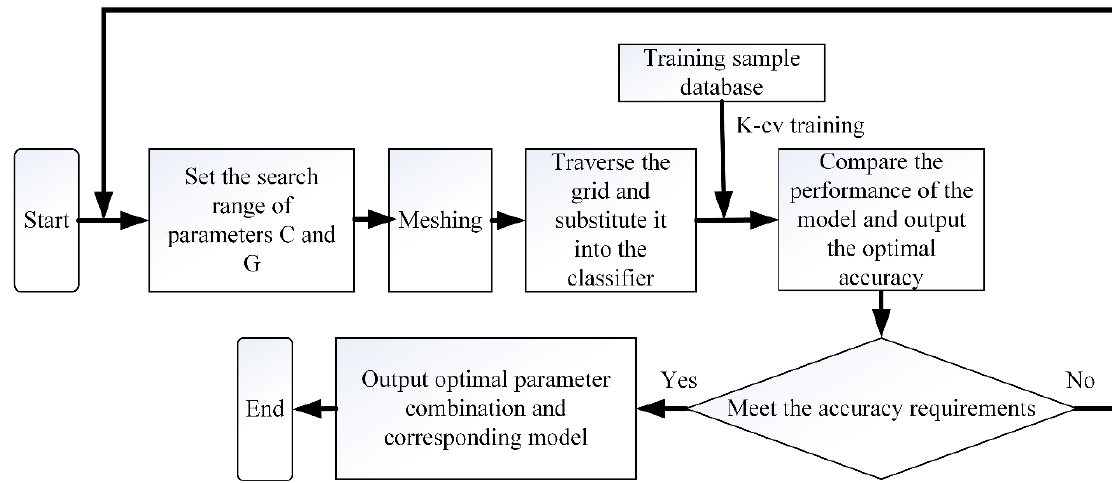
Figure 5. Flow chart of GridSearchCV.